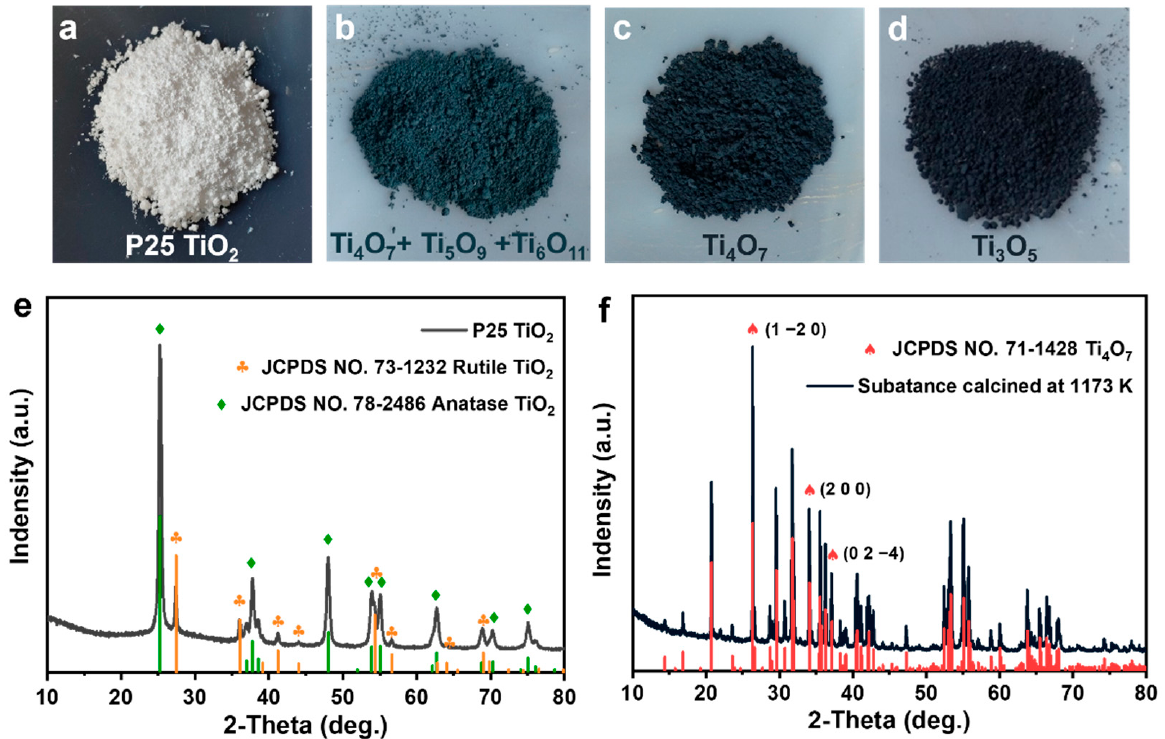
Figure 1. Digital photos of ( a ) P25 TiO 2 , substance calcined at ( b ) 1123 K ( c ) 1173 K ( d ) 1223 K. XRD patterns of ( e ) P25 TiO 2 ( f ) substance calcined at 1173 K.